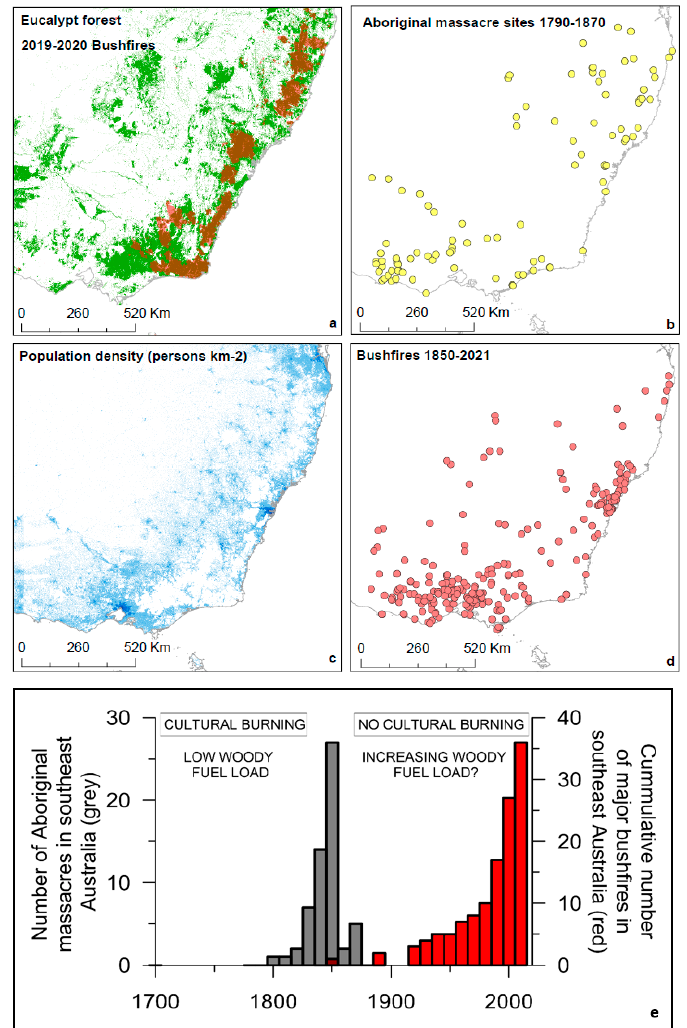
Figure 1. ( a ) Distribution of temperate eucalypt forests (green) and the 2019/2020 bushfire burn area (red) [17]; ( b ) Aboriginal massacre sites between 1780 and 1870 [18]; ( c ) population density [19]; ( d ) the location of all recorded bushfires in Southeast Australia (1850–2021) [20]; and ( e ) a time-series plot of massacres (grey) and a cumulative plot of recorded catastrophic bushfires in Southeast Australia (red).